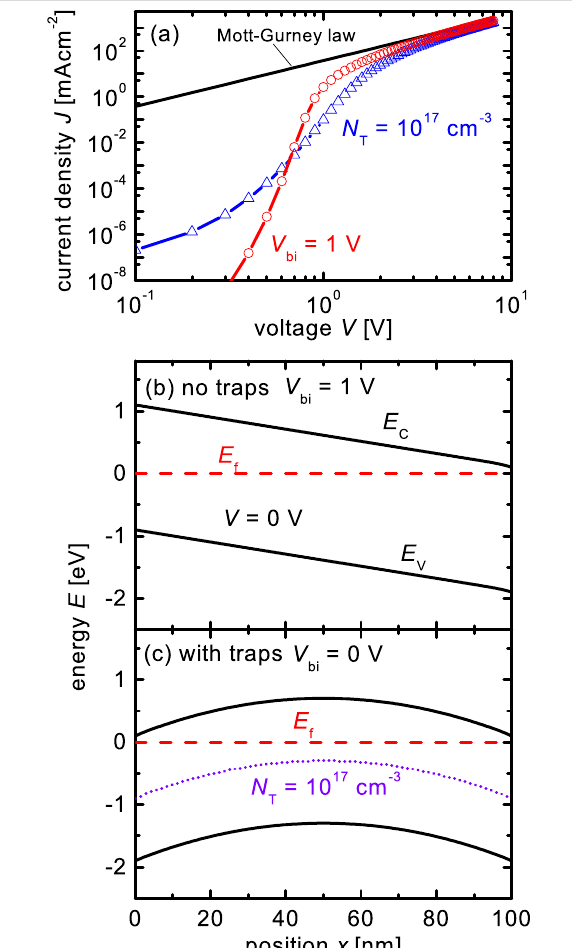
Figure 3: Normalized mobility obtained by fitting the Murgatroyd equa- tion to the simulated current–voltage curves of electron-only devices as a function of the concentration of midgap defects. The fitted mobility is normalized to the actual mobility that is used as an input parameter in the simulation and the built-in voltage in Equation 8 is a free para- meter. The actual built-in voltage used as input for the simulated cur- rent–voltage curves is zero. The comparison between fitted and actual mobility is done for two situations, one (lines + filled squares) with only a variable concentration of midgap defects and one (lines + open trian- gles) with the same variable concentration of defects and additional exponential